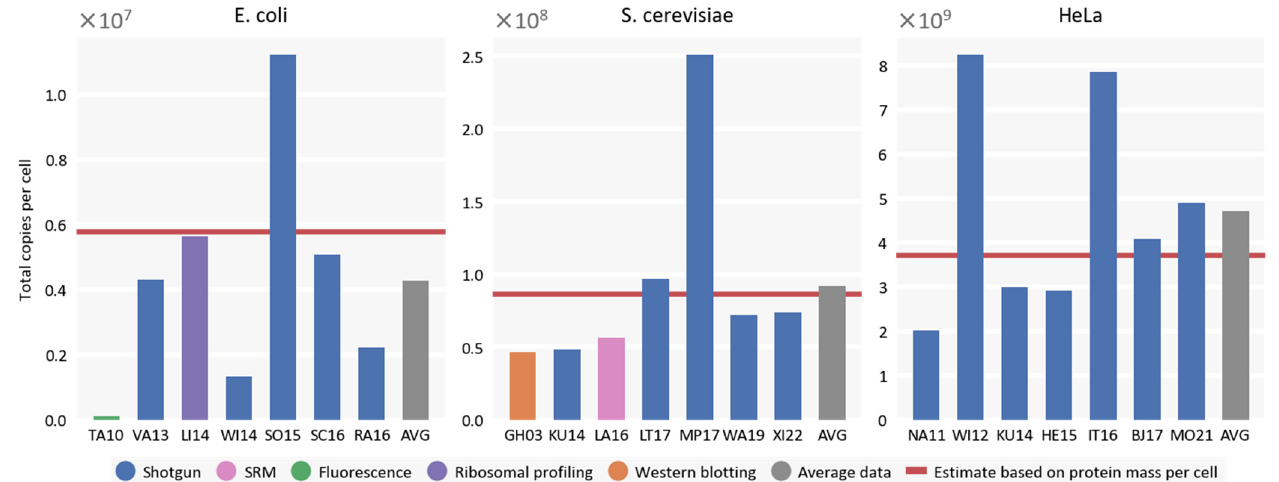
Figure 6. Comparisons of reported numbers of total protein copies per cell and the average values with estimates from total protein mass per cell.